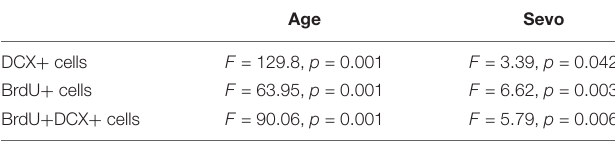
TABLE 4 | Two-way ANOVA analysis of AHN in adult and aged mice. Age Sevo